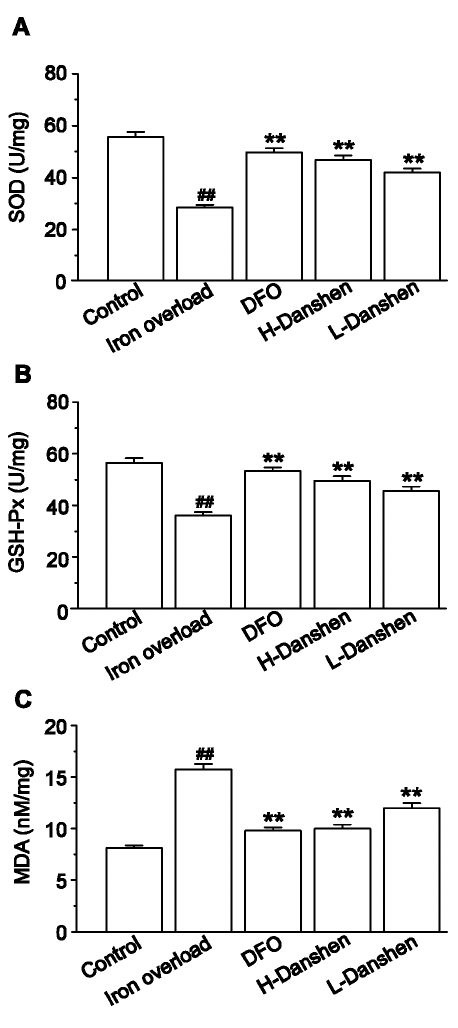
Figure 7. Effects of Danshen injection on concentration of MDA and activities of SOD and GSH-Px. SOD activity (A), GSH-Px activity (B) and MDA concentration (C) were measured in kidney homogenates of the control, iron overload, DFO, H-Danshen and L-Danshen groups. Data are presented as means 6 S.E.M of 15 animals per group. **P , 0.01, compared with iron overload group; ## P , 0.01, compared with control group.